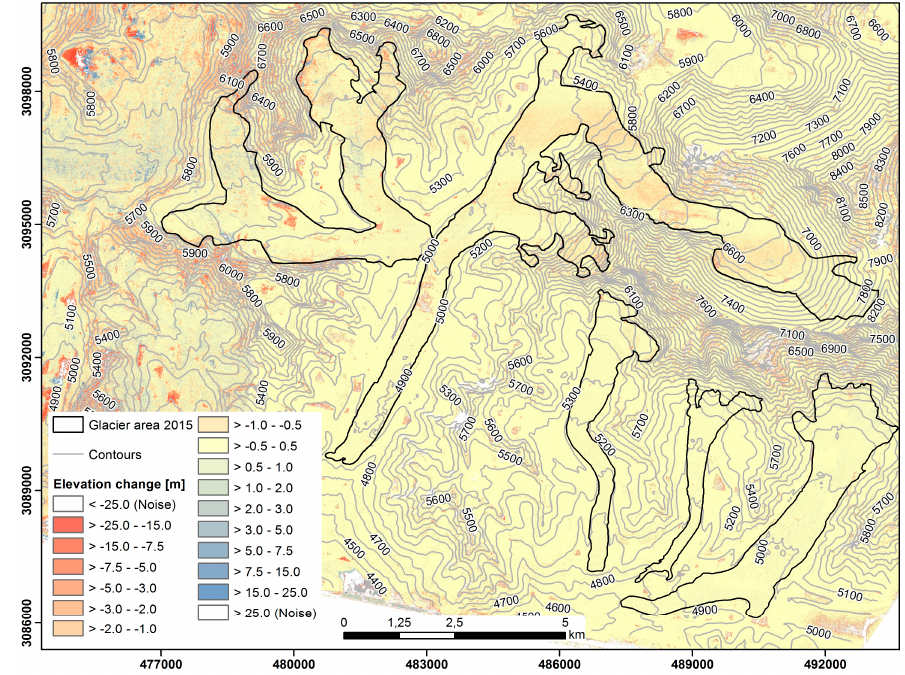
Figure 16. Winter surface elevation change of the Khumbu, Lhotse Nup, Nuptse, and Lhotse glaciers. UTM 45 N.